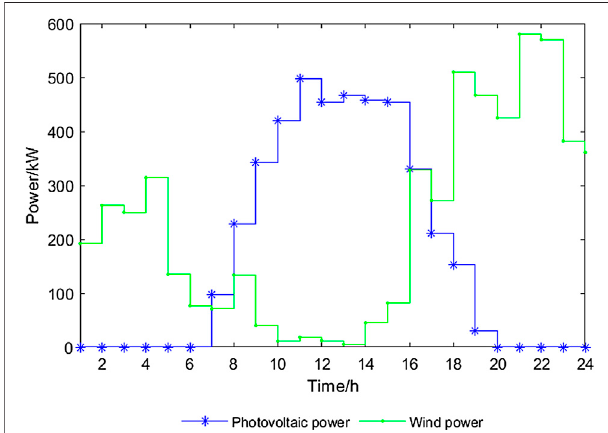
TABLE 2 | Other device parameters in the